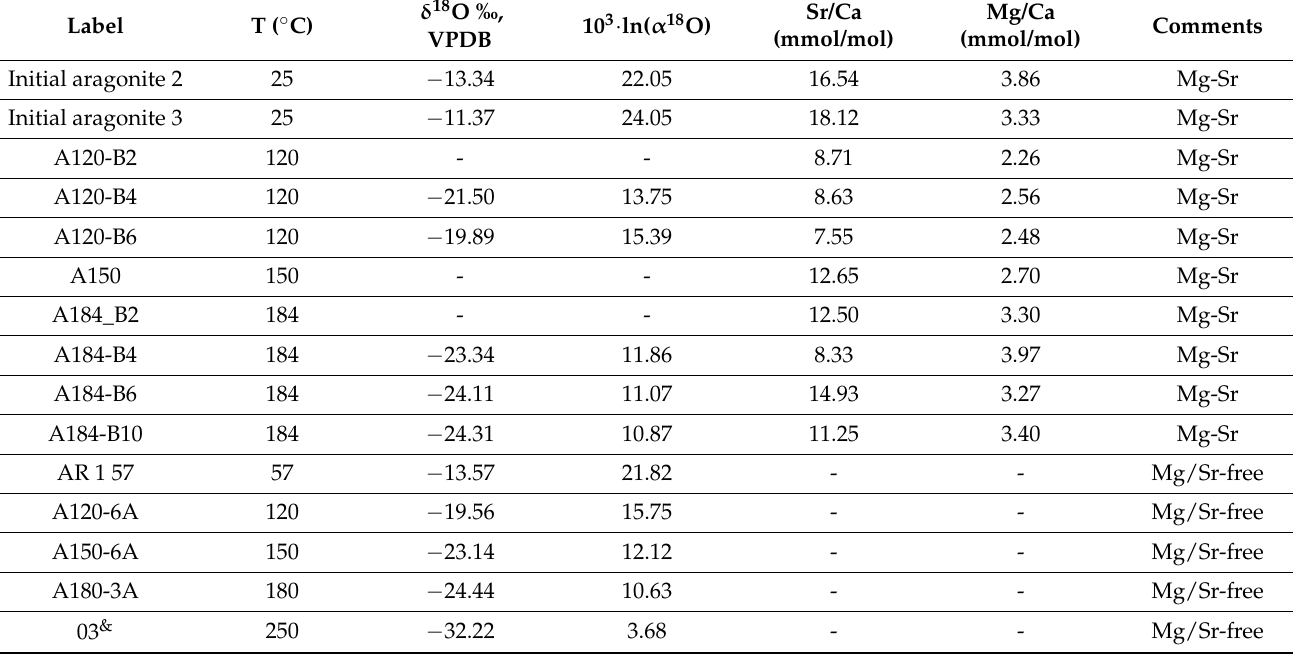
Figure 7. Oxygen isotope fractionation from multiple experiments at different temperatures. Red circles present data from experiments using Mg and Sr carrying aragonite; blue triangles present data from Mg- and Sr-free aragonite experiments; purple cross symbols present data from [30,31]. Table 2. δ 18 O, Sr/Ca, and Mg/Ca values in the initial aragonite and experimental samples at different